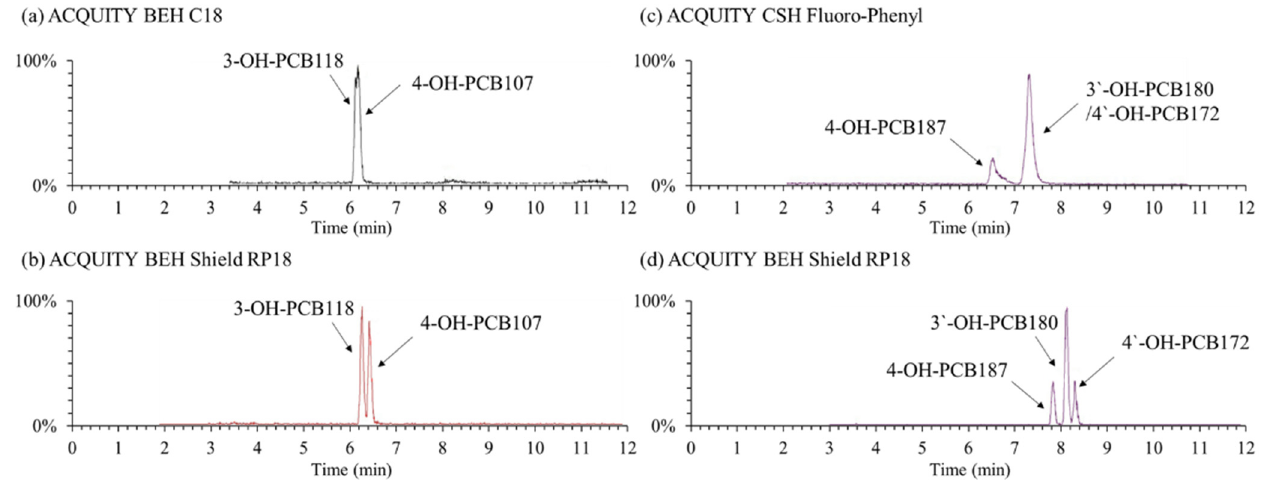
Figure 2. Example total ion chromatogram of typical OH-PCB congeners under the separation of different columns. Mobile phases were 0.1% formic acid-water ( a ) /0.1% formic acid-methanol ( b ) and the gradient elution program was 0–2 min, 25% ( a ); 2–10 min, 10% ( a ); 10–12 min, 2% ( a ); 12–13 min, 25% ( a ); 13–15 min, 25% ( a ).